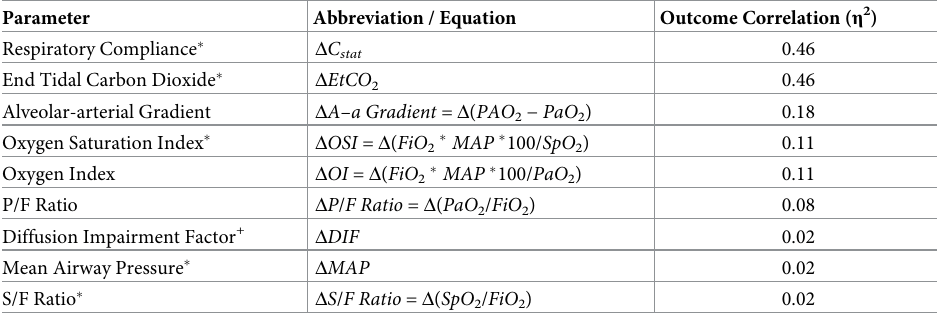
Table 1. The results of an outcome correlation statistical analysis.